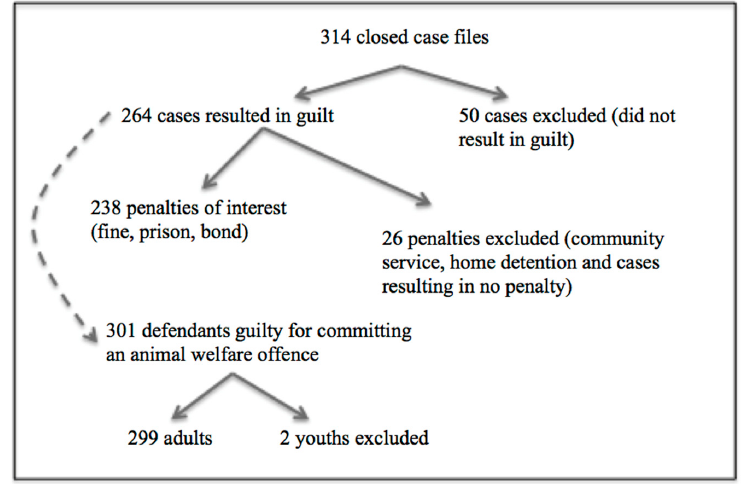
Figure 1. Flow chart of data processing and case exclusion.